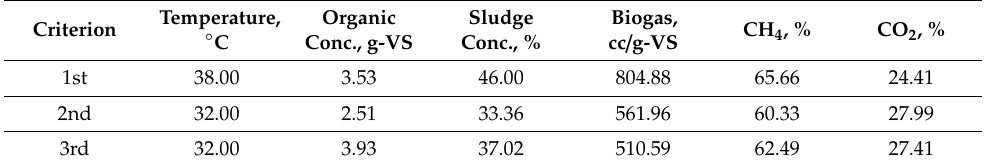
Table 9. The optimum results which were obtained by RSM.